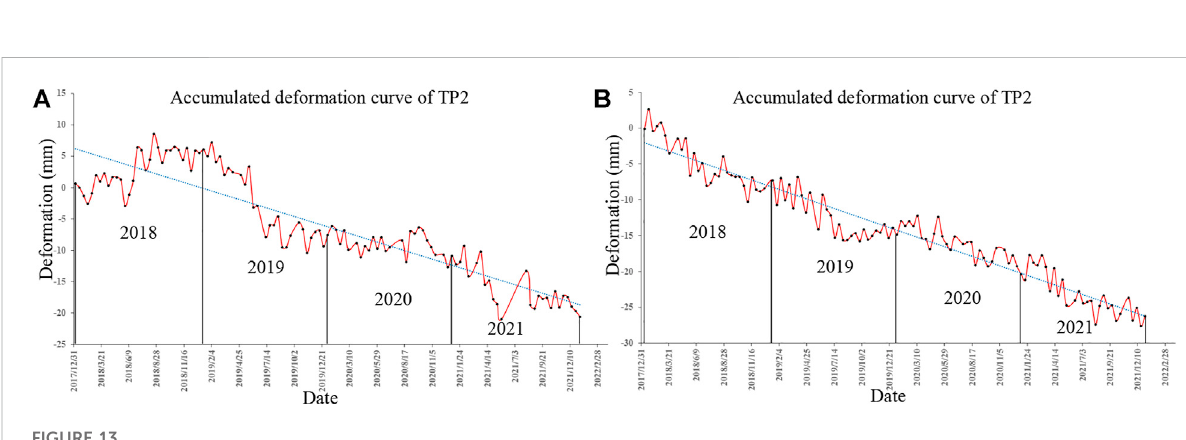
FIGURE 13 Time series deformation of TP2 on the QGE. (A) and (B) indicate the ascending and descending results,